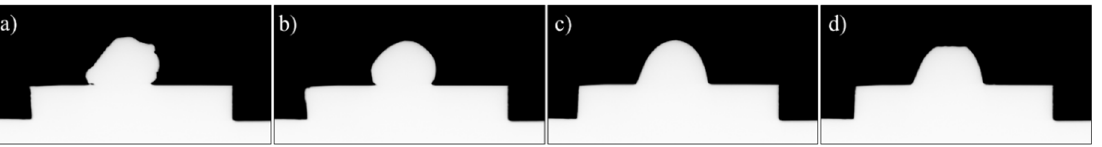
Figure 6. Drop profiles of Fe50_SPS in contact with pure Sn at ( a ) 0 s, ( b ) 100 s, ( c ) 600 s, and ( d ) 1200 s from melting.